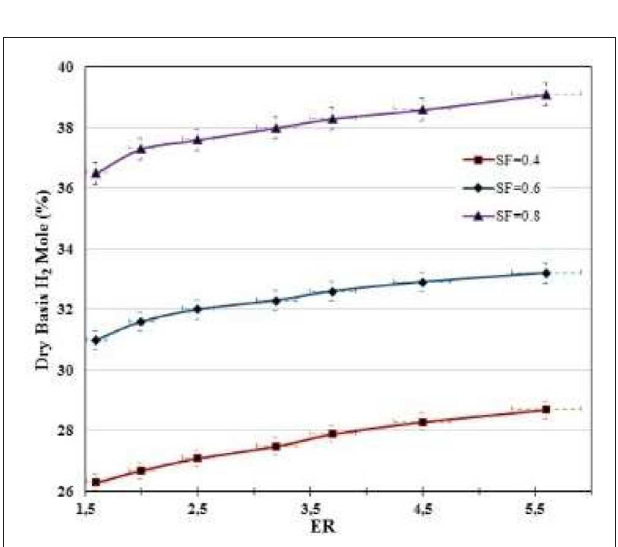
FIGURE 4 | H 2 production vs. ER for several SFs for air and oxygen gasification of